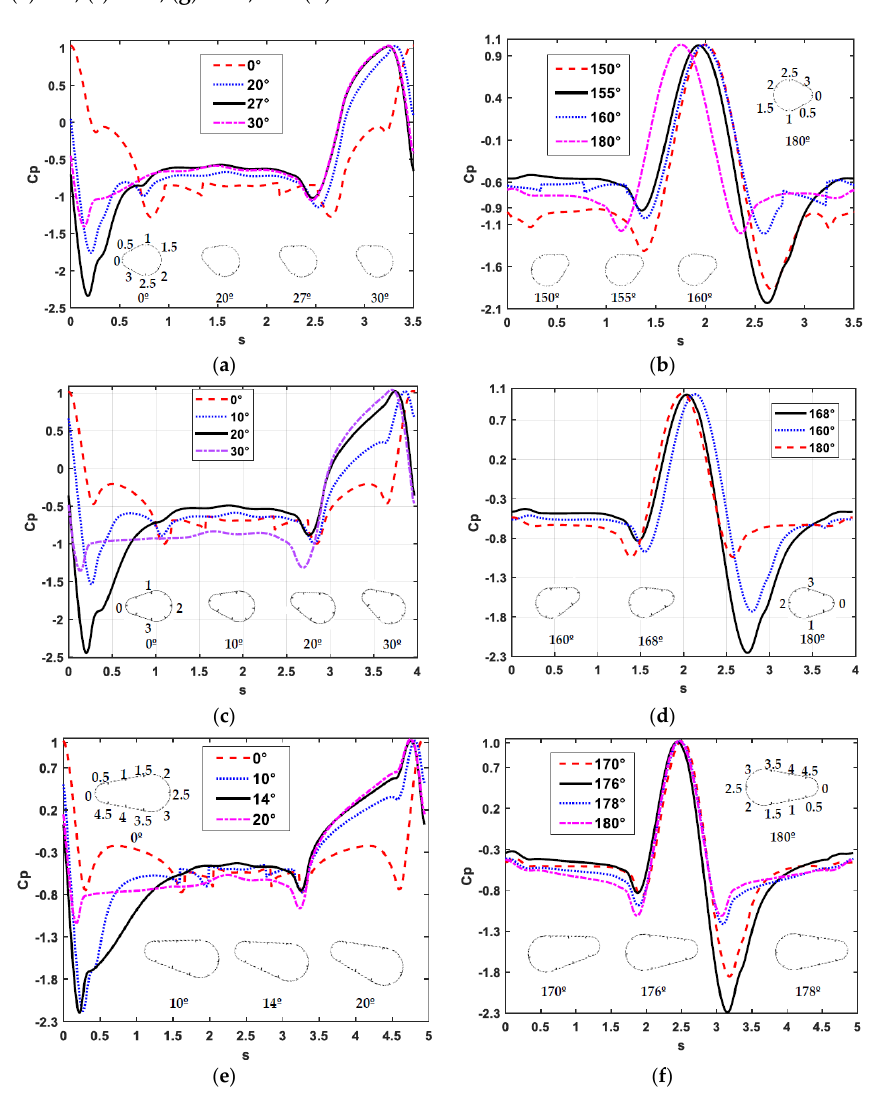
Figure 10. Distribution of mean pressure coefficient of iced conductor at different wind attack angle: α α ( a ) 0.25D- = 0°, 20°, 27°, 30°, ( b ) 0.25D- = 150°, 155°, 160°, 180°, ( c ) 0.5D- α α ( a ) 0.25D- α = 0 ◦ , 20 ◦ , 27 ◦ , 30 ◦ , ( b ) 0.25D- α = 150 ◦ , 155 ◦ , 160 ◦ , 180 ◦ , ( c ) 0.5D- α = 0 ◦ , 10 ◦ , 20 ◦ , 30 ◦ , ( d ) 0.5D- = 160°, 168°, 180°, ( e ) 1.0D- = 0°, 10°, 14°, 178°, 20°, ( f ) 1.0D- ( d ) 0.5D- α = 160 ◦ , 168 ◦ , 180 ◦ , ( e ) 1.0D- α = 0 ◦ , 10 ◦ , 14 ◦ , 178 ◦ , 20 ◦ , ( f ) 1.0D- α = 170 ◦ , 176 ◦ , 178 ◦ , 180 ◦ 180°.